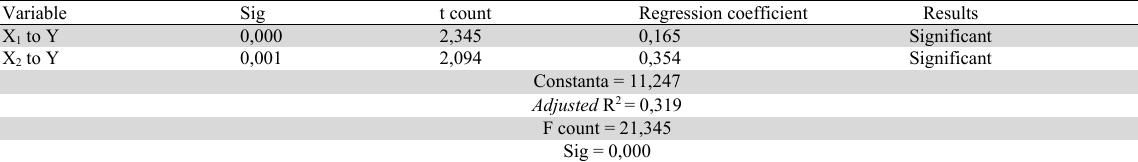
Results of Multiple linear regression Variable